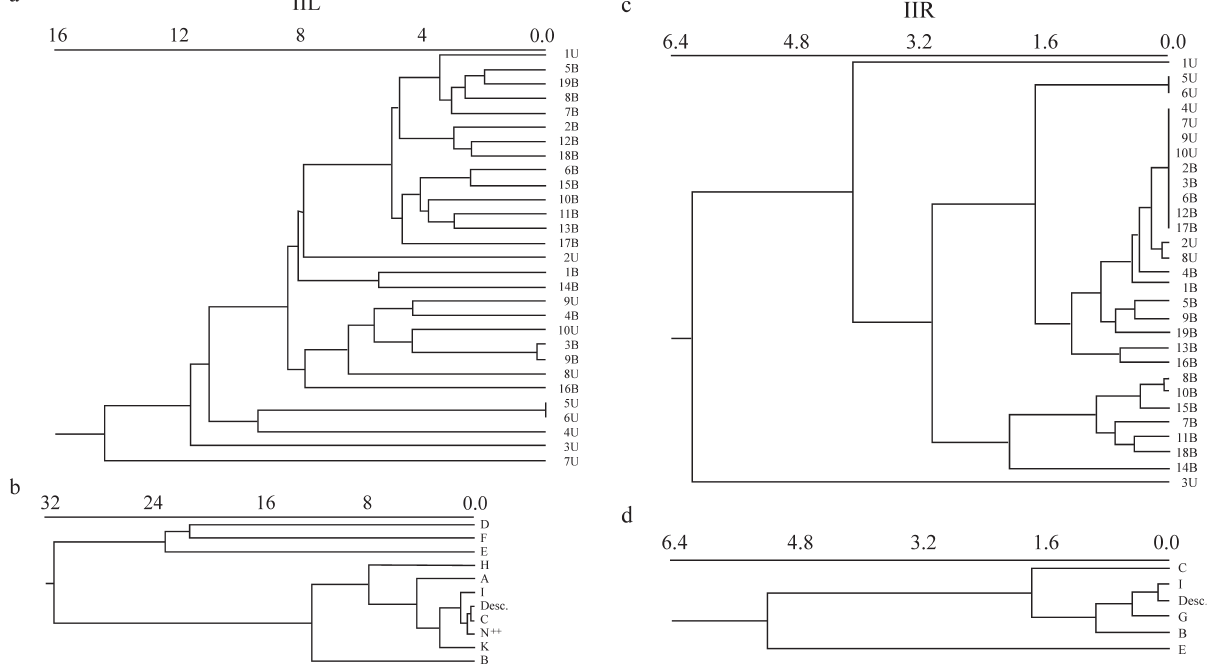
Figure 3 - Relationships among D. willistoni populations from Uruguay and Rio Grande do Sul based on the similarities/dissimilarities of the inversions on chromosome arms IIL (a,b) and IIR (c,d) using the UPGMA method. (a) Cluster based on the frequencies of heterozygous inversions in IIL and (b) the contribution of each type of IIL inversion to the clustering in (a). (c) and (d), as in (a) and (b) but for chromosome arm IIR. Population samples as in Table 2, but see also Valente et al. (1993) and Appendix